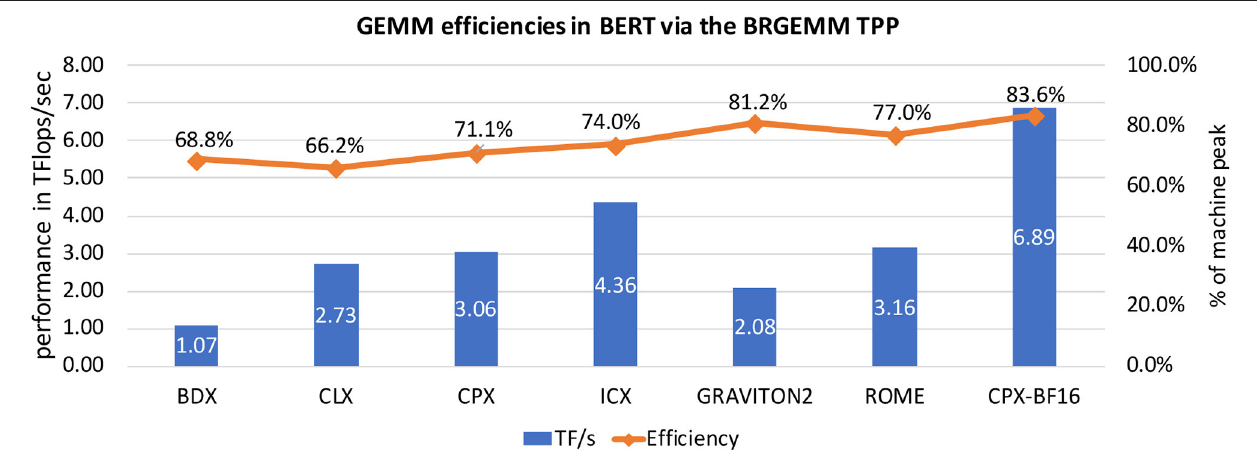
FIGURE 27 | BERT GEMM/tensor contraction efficiencies via the BRGEMM-TPP on multiple platforms.